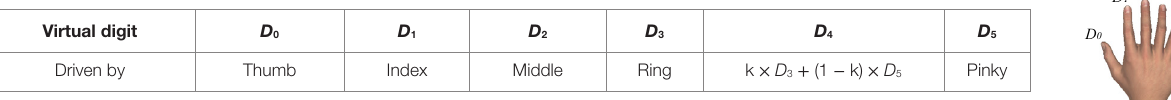
TaBle 1 | animations of the virtual digits were driven in real-time using the corresponding mapping.